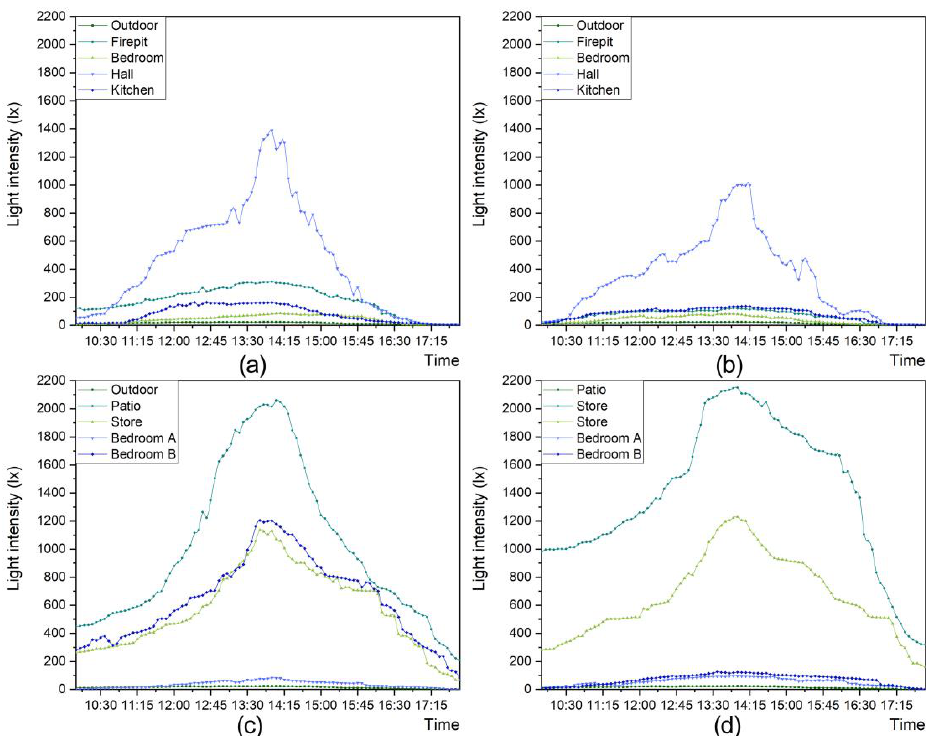
Figure A3. Indoor PM 10 concentration monitoring results. ( a ) Zuozi dwelling [34], ( b ) L-shape dwell- ing [34], ( c ) lower store and upper house dwelling, ( d ) front store and back house dwelling.